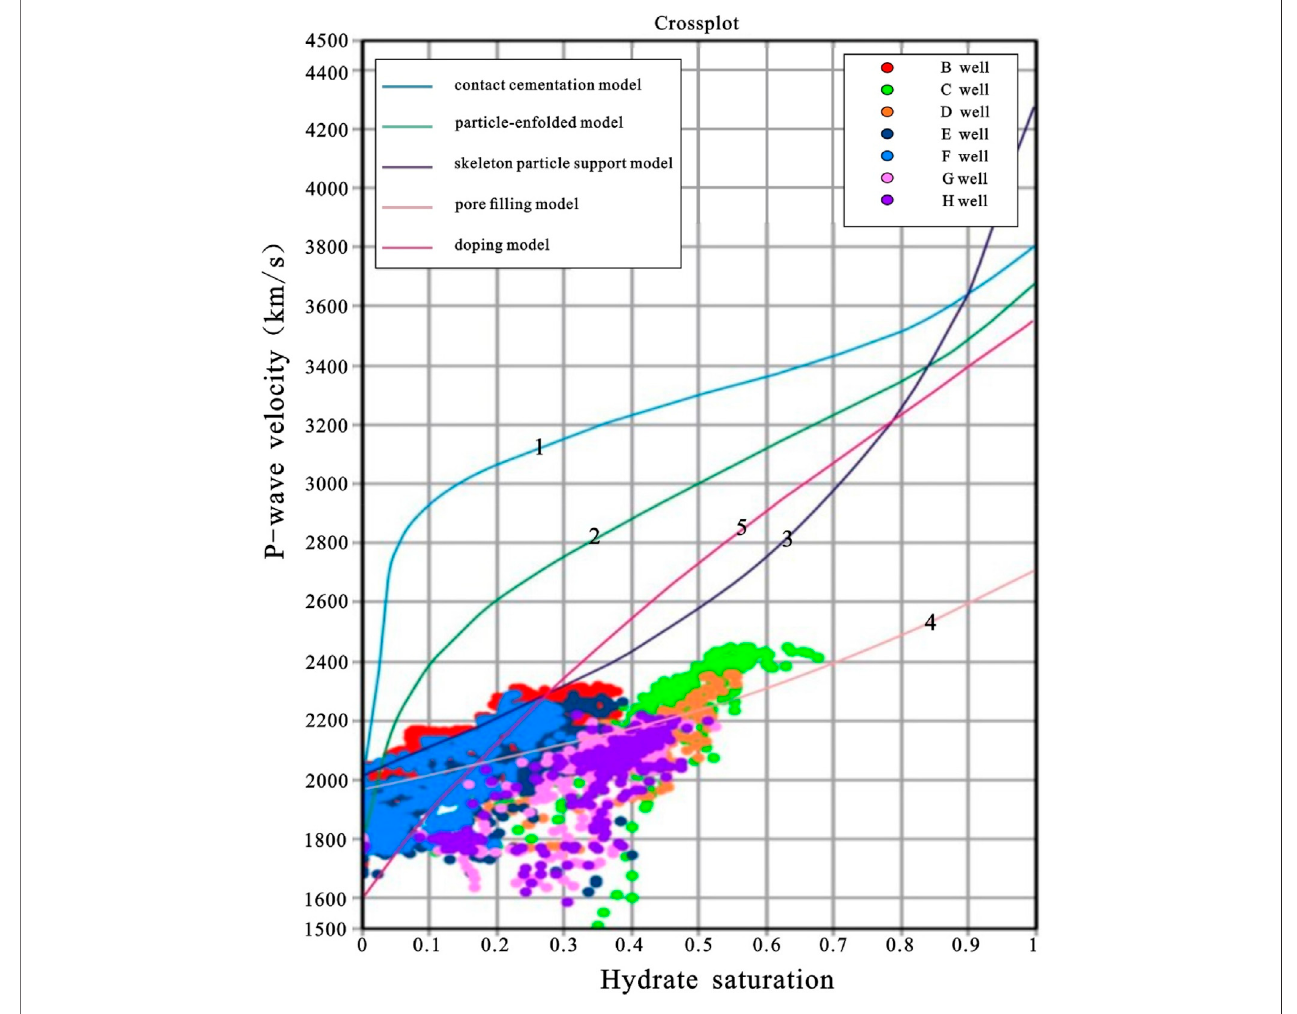
FIGURE 7 | Rock physics template for fi ve classic hydrate